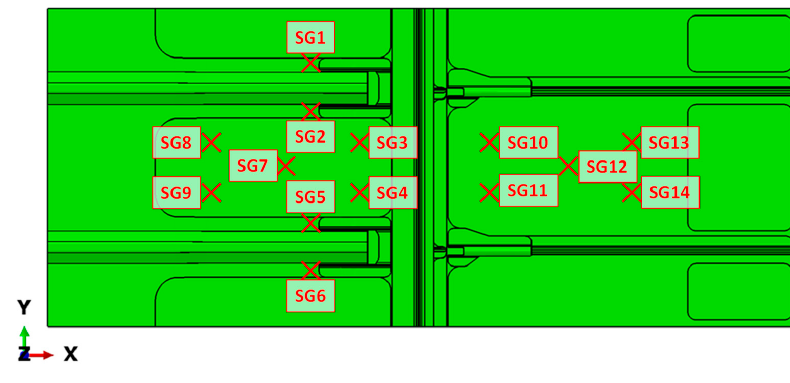
Figure 5. Strain gauge locations.